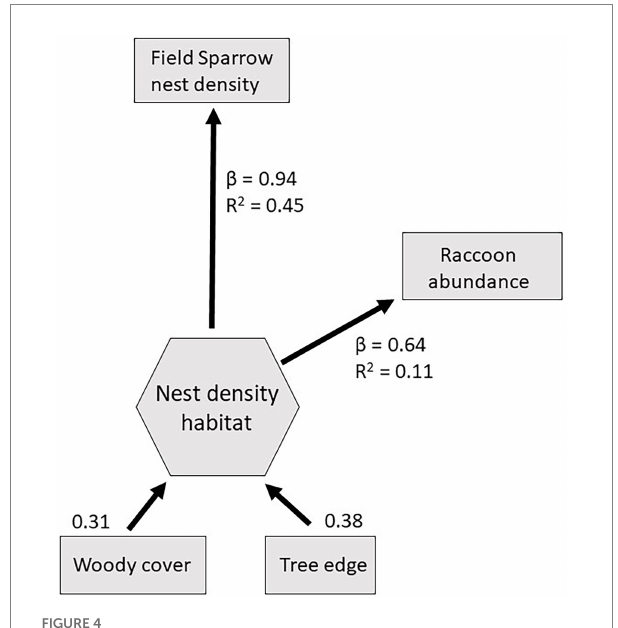
FIGURE 4 Structural equation model comprised only of significant ( p < 0.1) paths, examining direct and indirect effects of habitat characteristics on Field Sparrow nest density. The regression coefficient ( β ) and marginal R 2 value are shown for each path. The loading for each component of the composite habitat variable is listed above the